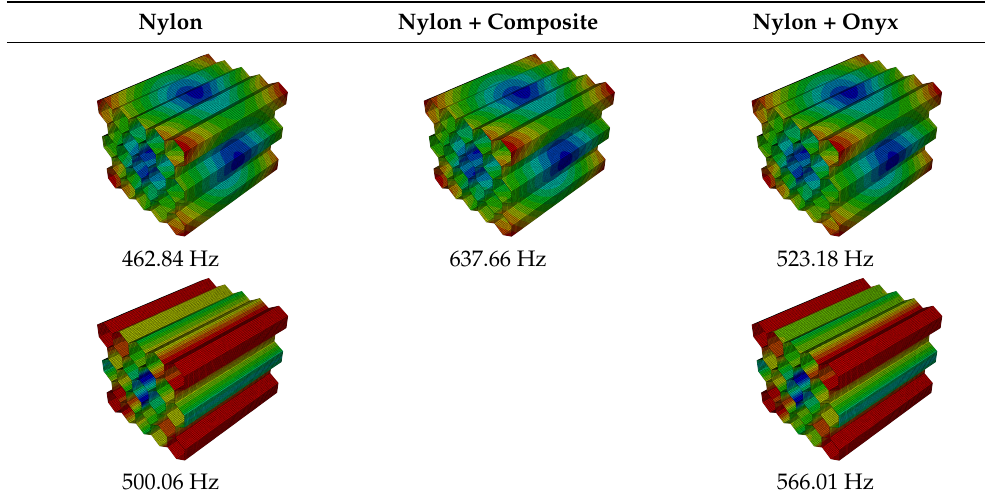
Table 4. First five paired mode shapes of Honeycomb Lattice Structure free–free.